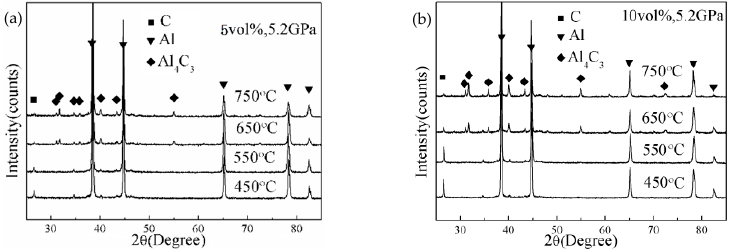
Figure 6. XRD patterns of the sintered with G content of ( a ) 5 vol.% and ( b ) 10 vol.%, at different temperatures under 5.2 GPa.